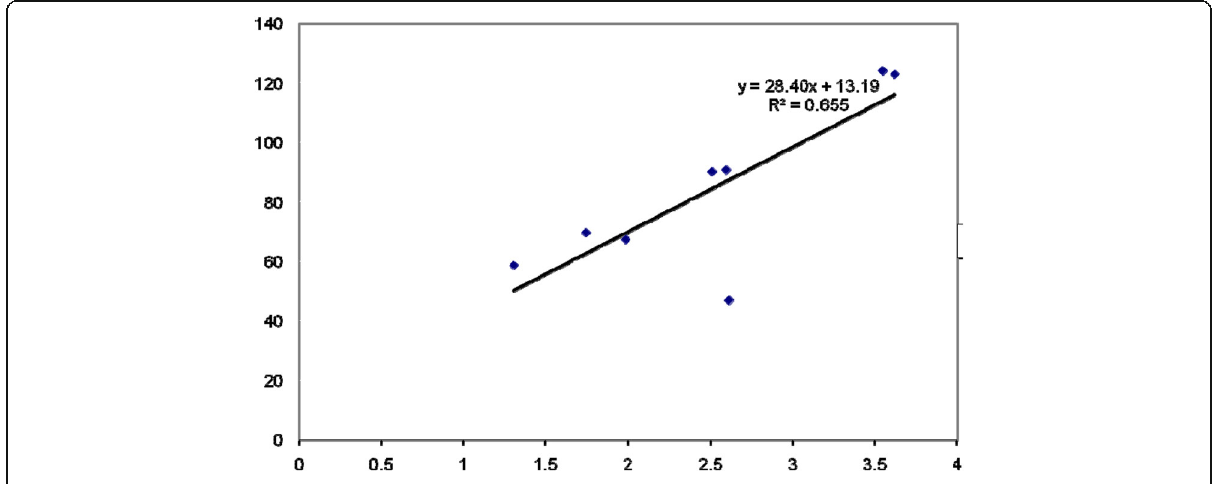
Fig. 1 LD determination curve of bee venom (13.19 mg/kg b.w.)